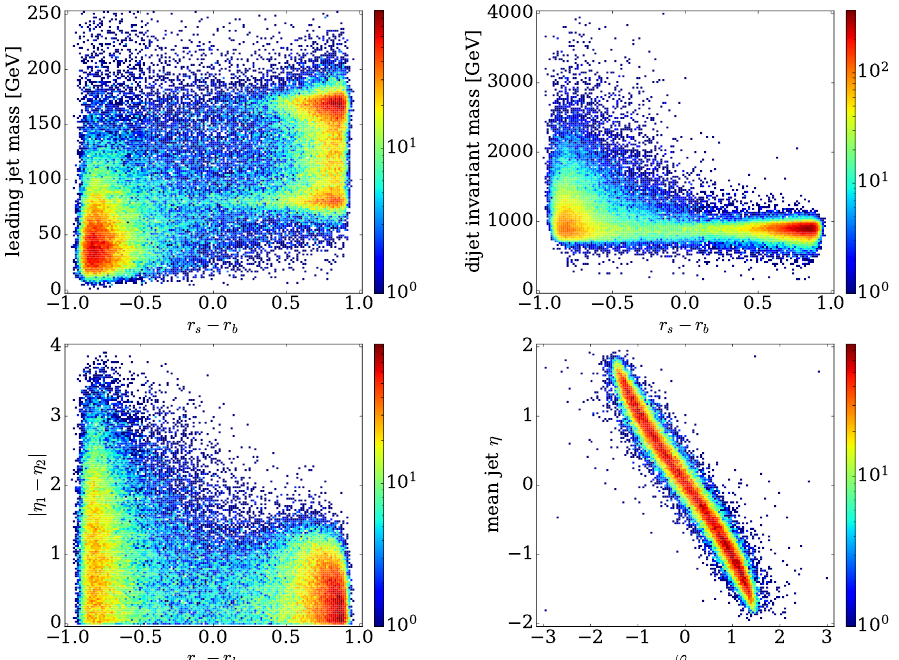
− r and the leading jet mass, S B for true signal j